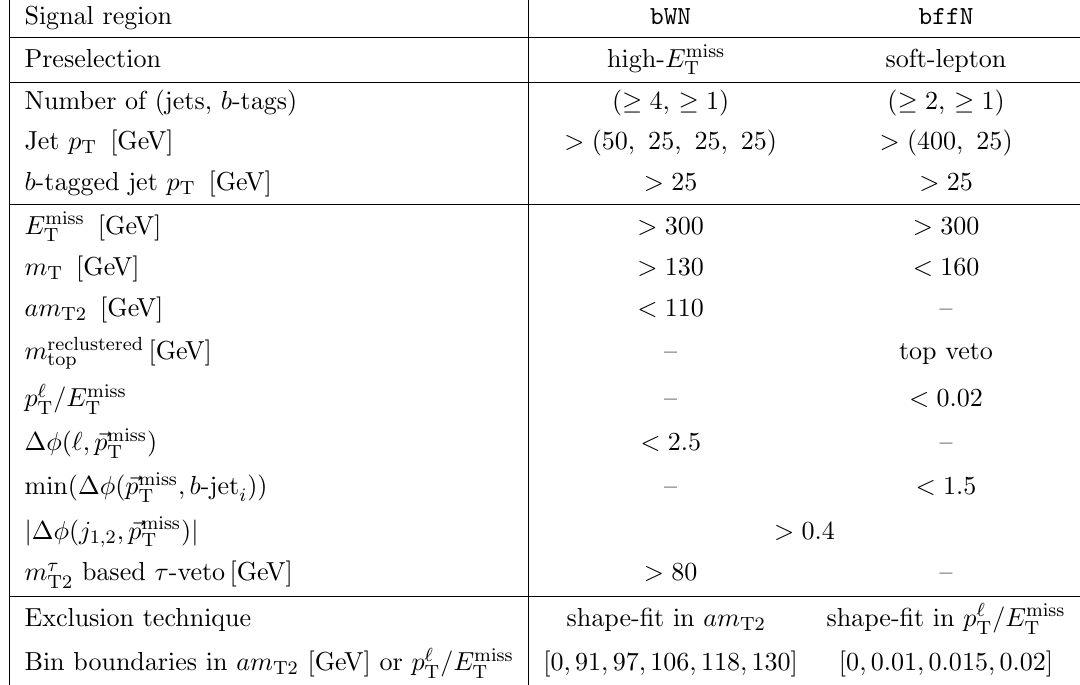
Table 8 . Overview of the event selections for the bWN and bffN SRs. List values are provided in between parentheses and square brackets denote intervals. The veto on the reclustered hadronic top-quark candidate is satis(cid:12)ed for events where no reclustered jet candidate is found, or where the mass of the hadronic top-quark candidate ( m reclustered ) is below 150 GeV. For the bffN SR, the top leading jet is required to not be b